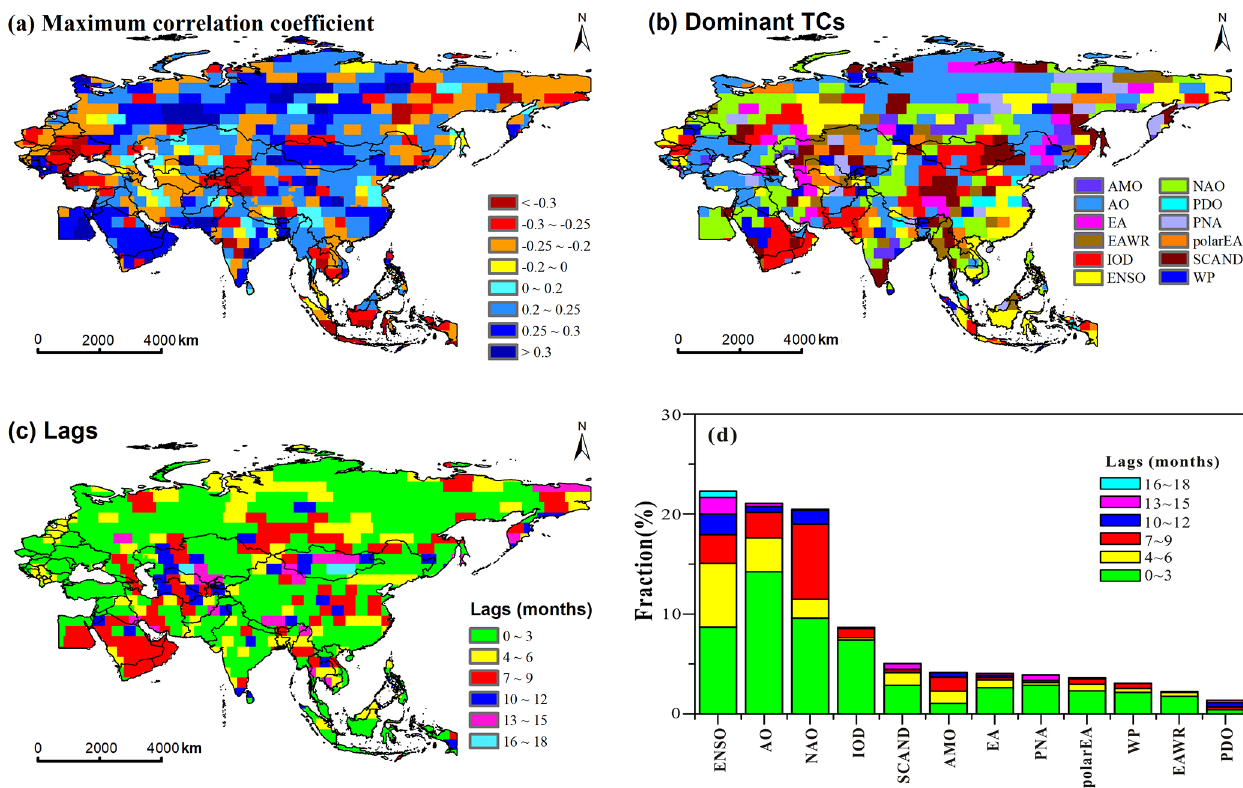
Figure 4. Spatial distribution of cross-correlation analysis between TWS and teleconnection indices. (a) Spatial pattern of maximum correla- tion coefficients between TWS and the teleconnection indices. (b) Spatial pattern of teleconnections that can most accurately represent TWS variations. (c) Spatial pattern of teleconnection lag time. (d) Proportion of the area dominated by each teleconnection and its corresponding time lags. The maximum lag in the correlation analysis was limited to 0–24 months (significance threshold: | r | > ∼ 0 . 15 given a significance level = 0 . 05 and a time series number =